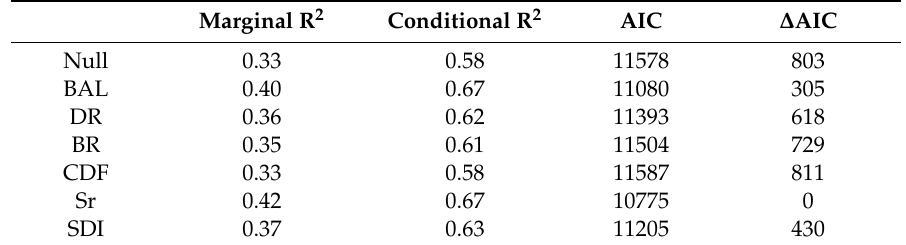
Table 5. Evaluation of the thinning intensity-independent single (TIS) model using each distance-independent competition index.